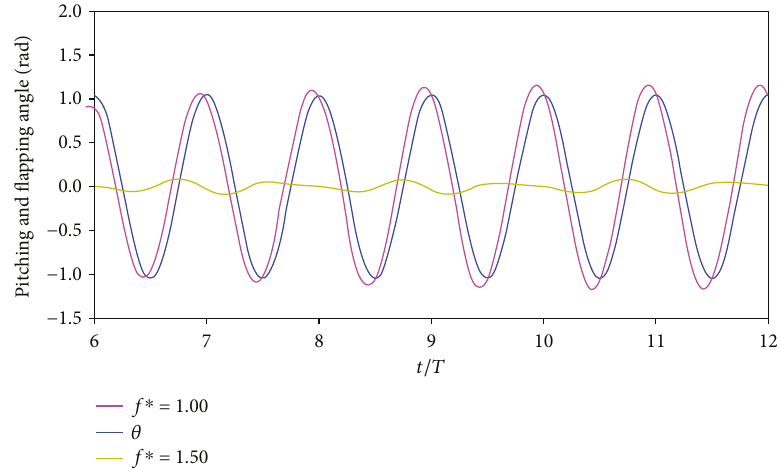
Figure 9: Time variation of passive pitching angle of fl exible wings with f ∗ = 1 00 and 1.50 and fl apping angle θ .